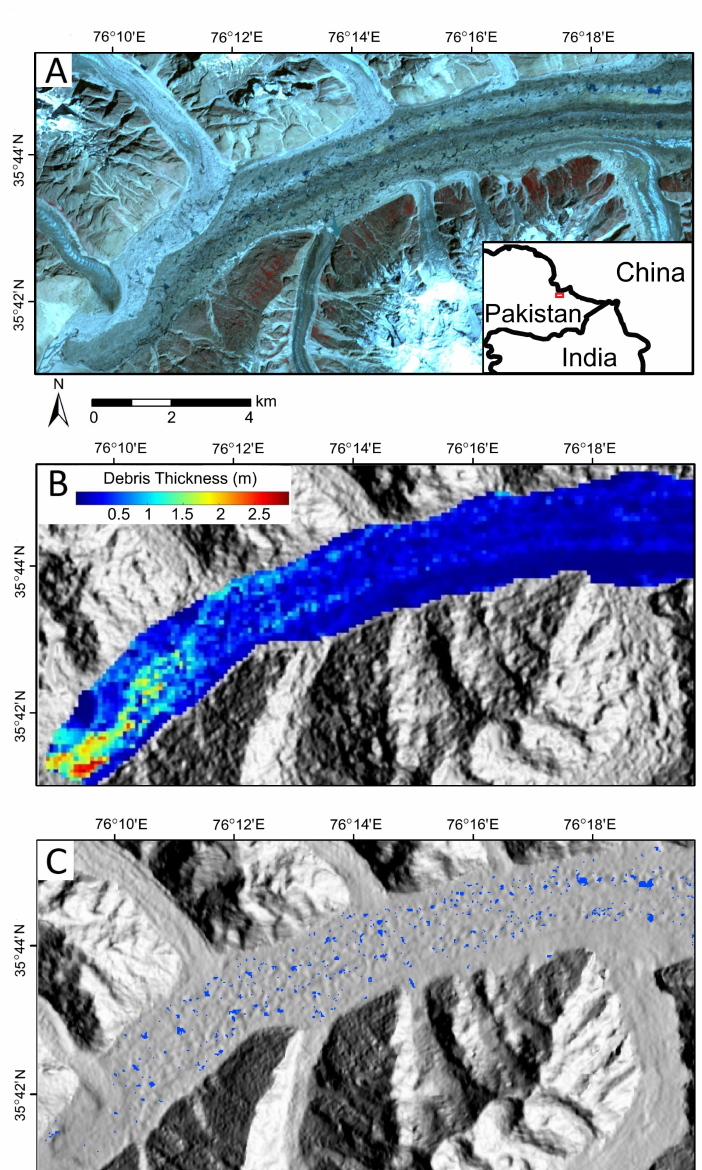
Figure 7. Example of mapping supraglacial features from remote sensing analysis. ( A ) An ASTER imagery of the lower ablation zone of the Baltoro Glacier acquired on 14 August 2004. ( B ) Debris thickness distribution estimated from surface kinetic temperature following Mihalcea et al.